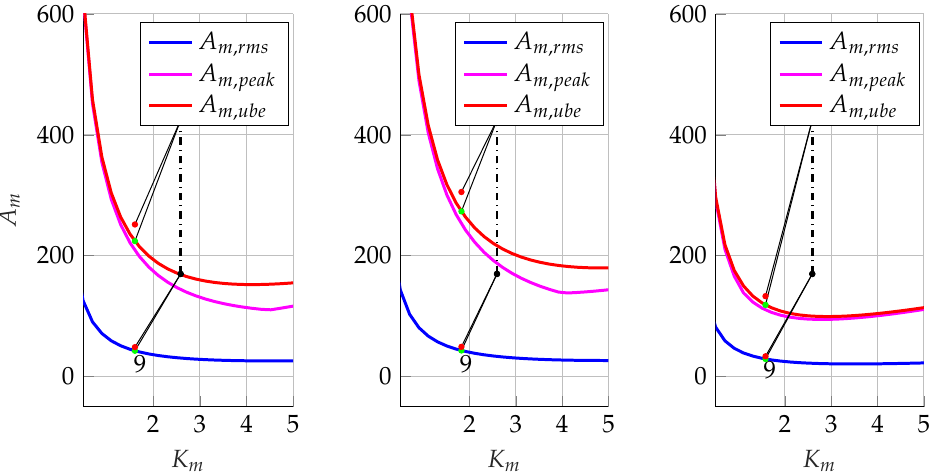
Figure 25. Feasible reduction ratios (7, 9 and 12) for power drive system 3 applied to axes 1 ( left ), 2 ( middle ) and 3 ( right ); inertial loads only.